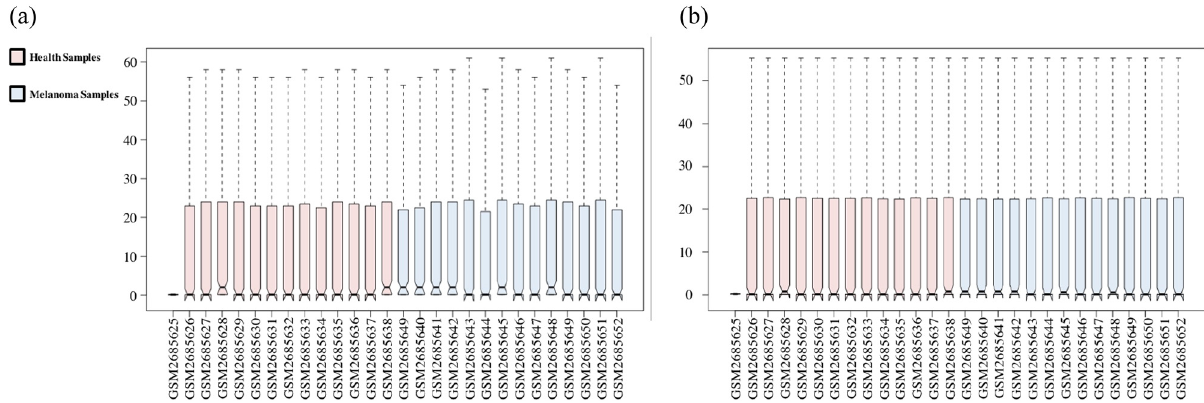
Figure 1: The GSE100508 microarray dataset obtained from the GEO database. ( a ) The microarray dataset before normalization. ( b ) The microarray dataset after normalization.